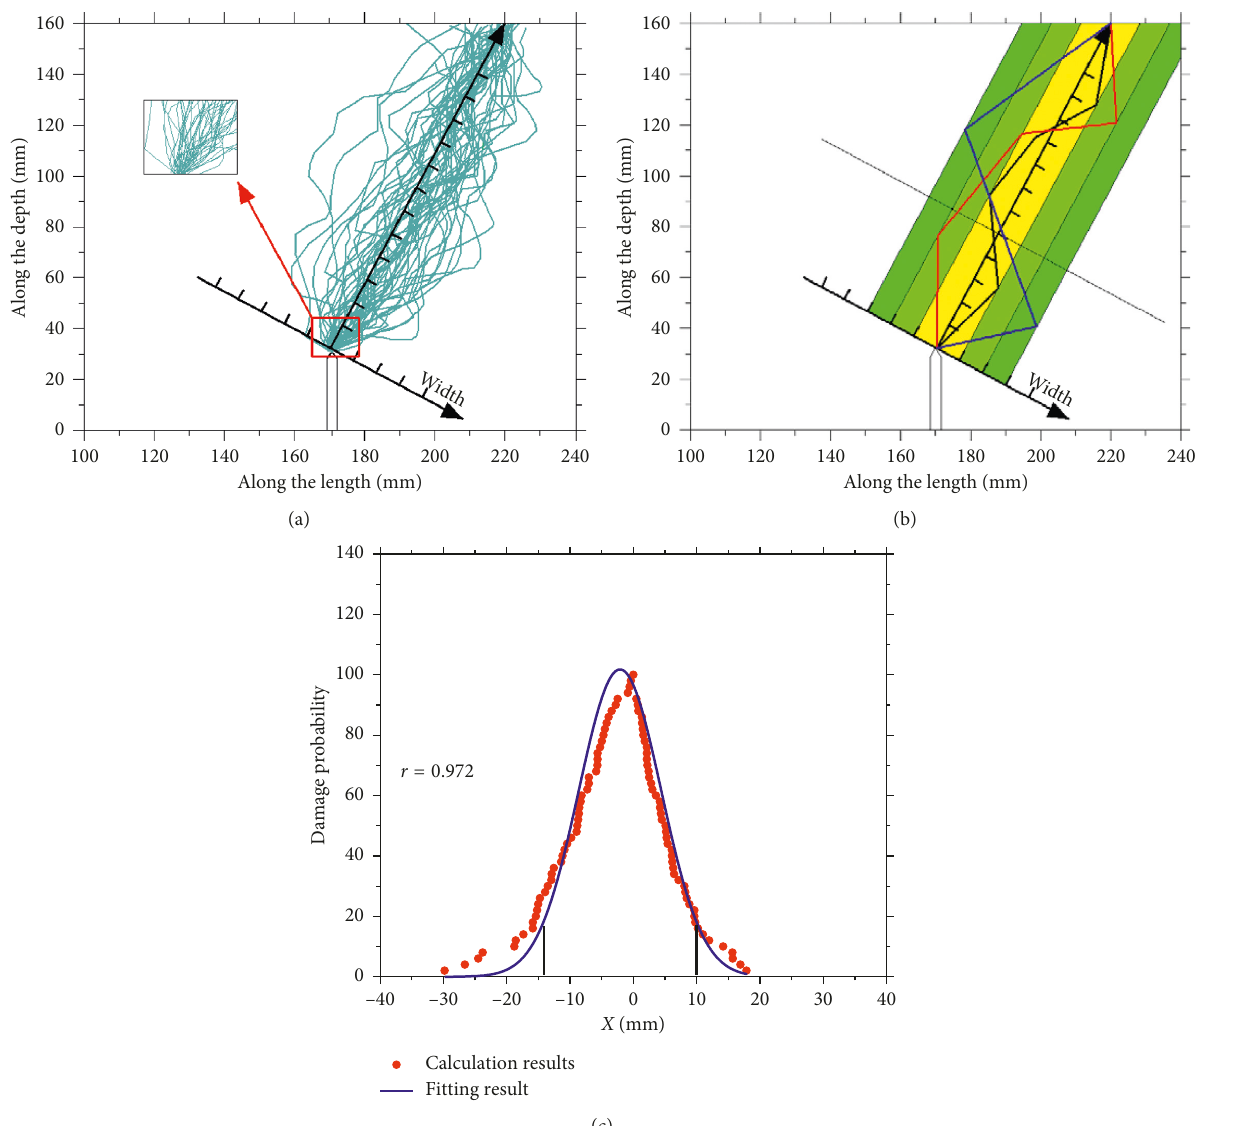
Figure 7: Schematic diagram of the (a) damaged bandwidth calculation, (b) damage probability calculation, and (c) damage probability calculation